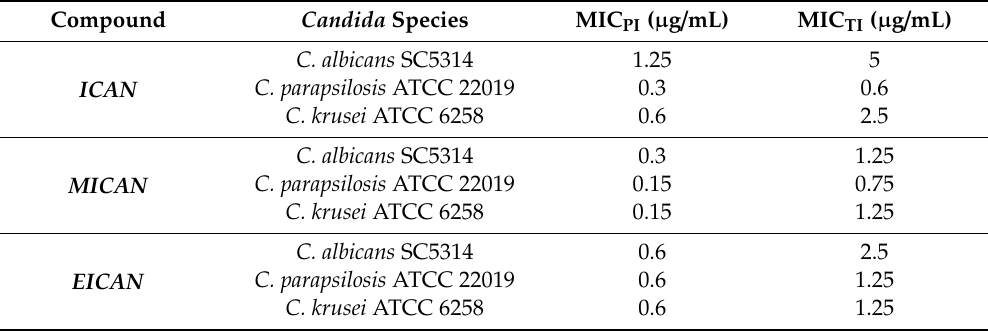
Figure 2. The development strategy for the most effective 1-amino-5-isocyanonaphthalene (ICAN) derivative. For the full names please refer to the experimental section of this paper. Table 1. In vitro susceptibilities of C. albicans SC5314, C. parapsilosis ATCC 22019, and C. krusei ATCC 6258 to various ICAN derivatives determined by the Clinical & Laboratory Standards Institute (CLSI) broth microdilution method. MICs were read using the partial (MIC PI ) and total inhibition (MIC TI ) criteria. [22]. For the full names and structures of the compounds please refer to Figure 2 and the experimental section of this paper. The lowest MICs are indicated in red. For the MIC TI values of AMB for these Candida strains please refer to Table 2.